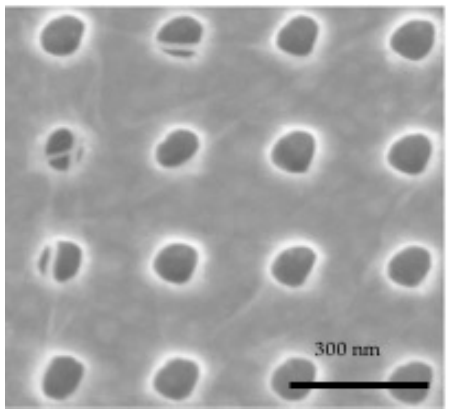
Figure 6. SEM images of EPD results for 2 s deposition times using 10 V for s-SWCNTs (semiconducting).